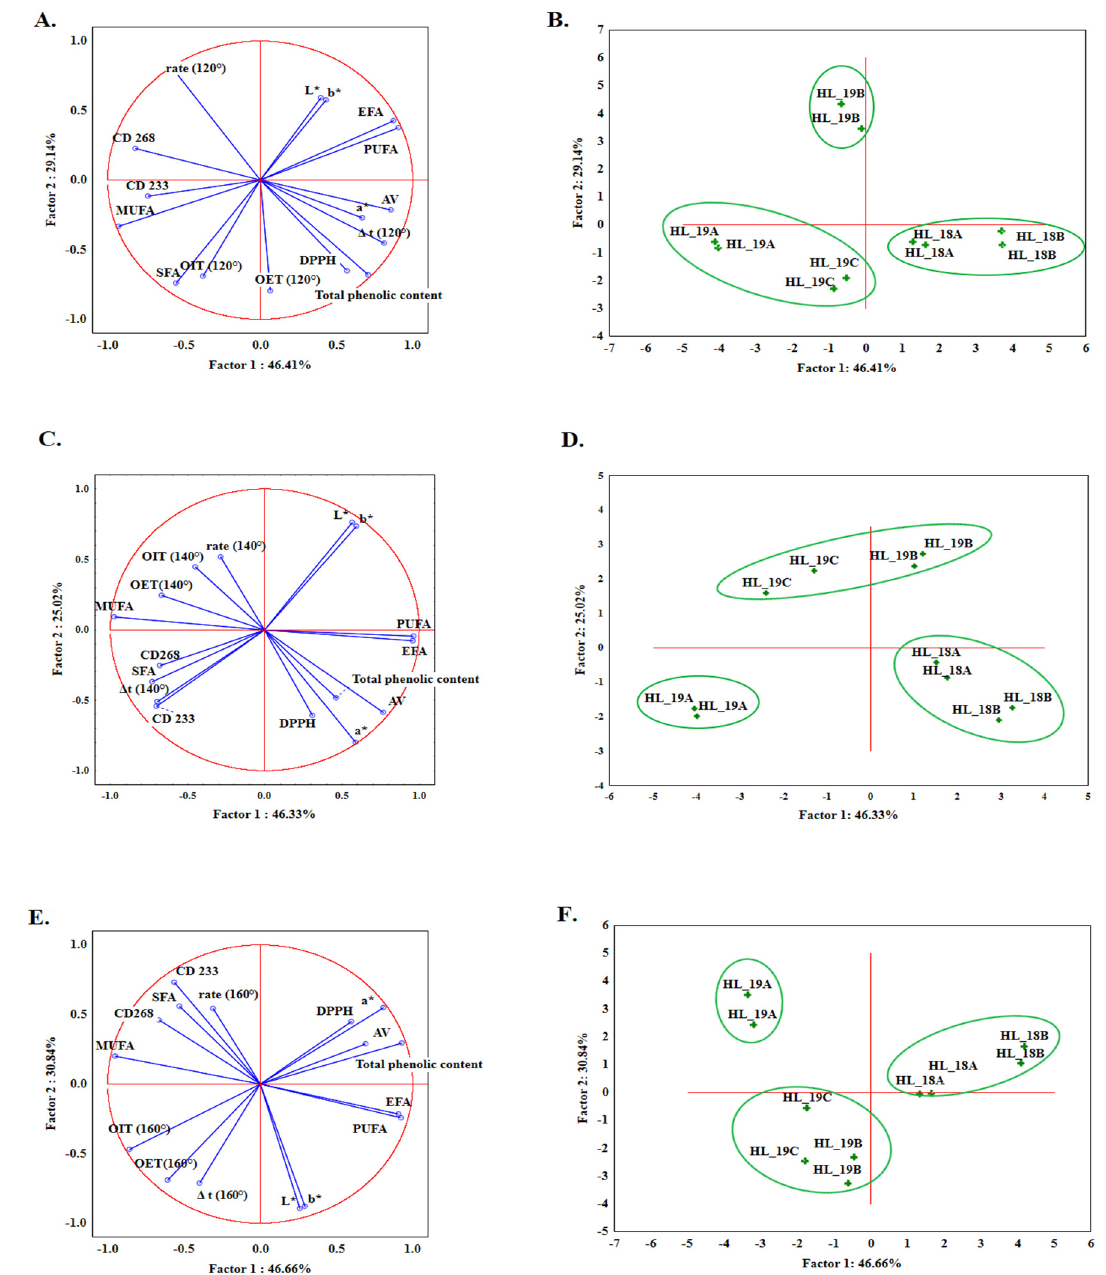
Figure 4. PCA analysis, the loading plots for PC1 and PC2 with projection of the variables: DSC parameters determined at 120 ◦ C ( A ), 140 ◦ C ( C ), and 160 ◦ C ( E ). and projection of cases showing the distribution of hemp seed oil samples analyzed at 120 ◦ C ( B ), 140 ◦ C ( D ), 160 ◦ C ( F